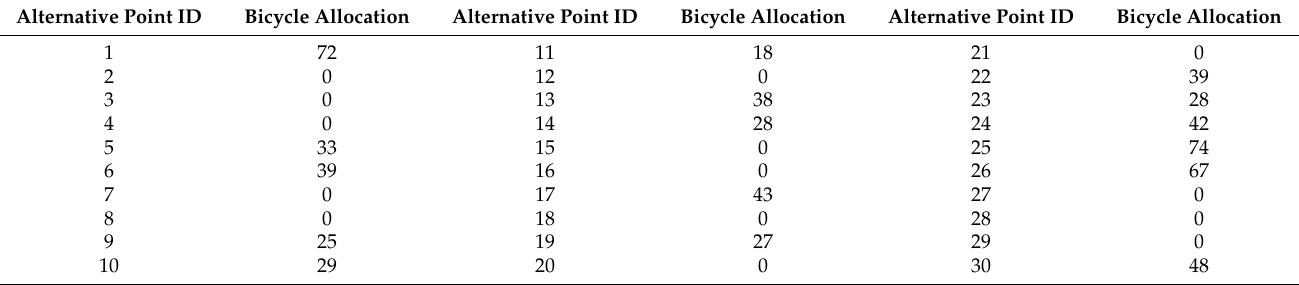
Figure 11. Optimal scheme of bike-sharing facilities with an upper limit of 80. Table 8. Optimal scheme and the number of bikes allocated with an upper limit of